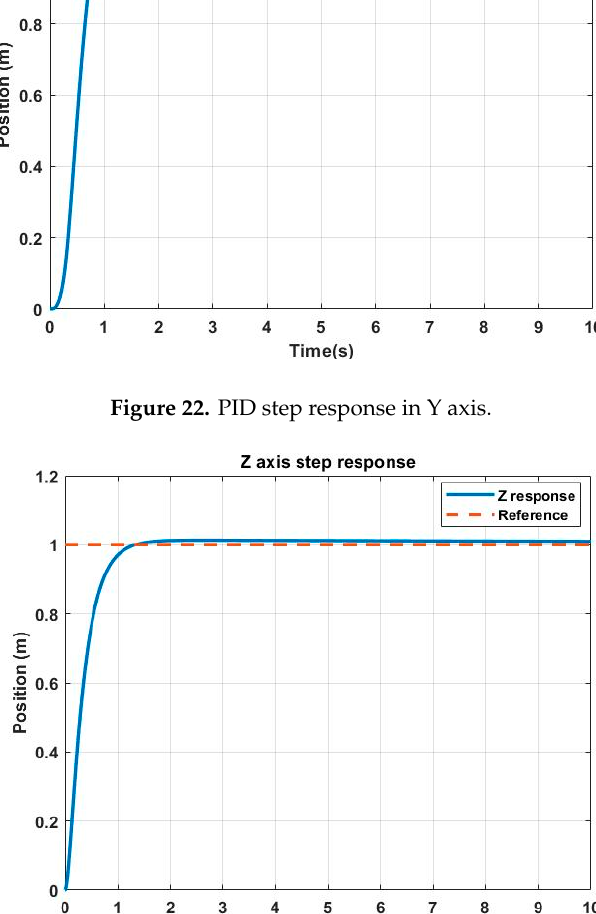
Figure 23. PID step response in Z axis.